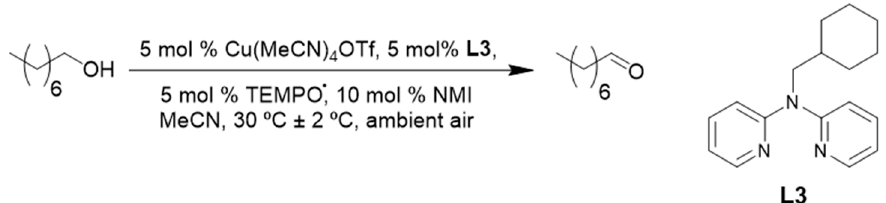
Figure 1. The Cu(BPYDCDE)(OAc) 2 complex for the base ‐ free catalyst system for alcohol oxidation [65] . Reproduced with permission from Han and co ‐ workers. Copyright American Chemical Society, 2018. Their catalyst system, operating at ambient temperatures and pressures, could be used for the conversion of a variety of primary and secondary alcohols to the corresponding aldehydes and ketones in a short reaction time, without the addition of external base [65]. The coordination between the ligand and OAc ‐ enriches the electron population on the Cu ‐ centre, increasing the alkalinity of the OAc ‐ counter ion to afford a better leaving group. The activity of the different complexes are governed by the metal, the alkalinity of the counter ion as well as the structure of the ligand. Furthermore, they also found that the Cu II ‐ complex could be recycled for up to five times without the loss of activity [65]. Independently, Liu and co ‐ workers also reported a CuI/NMI/TEMPO · (ratio of 1:2:1) catalyst system, in the absence of an external base, for the oxidation of both primary and secondary (partially successful) alcohols to their corresponding carbonyl products, under ambient conditions and